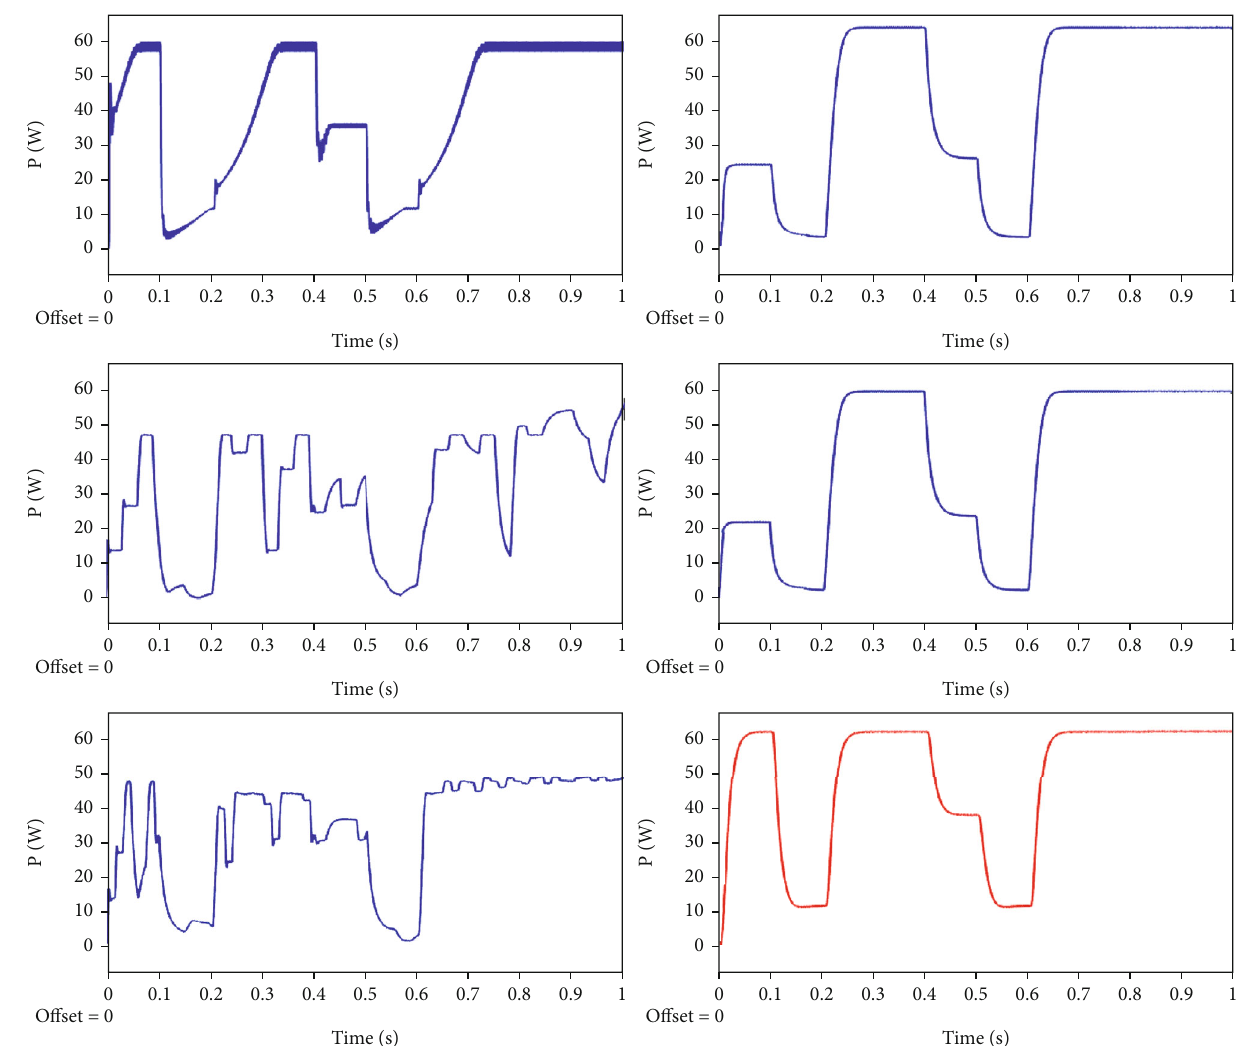
Figure 11: Simulation waveforms at the extreme very fast change in insolation. PV array output power P&O, PSO, CUCKOO, GWO, WOA, and